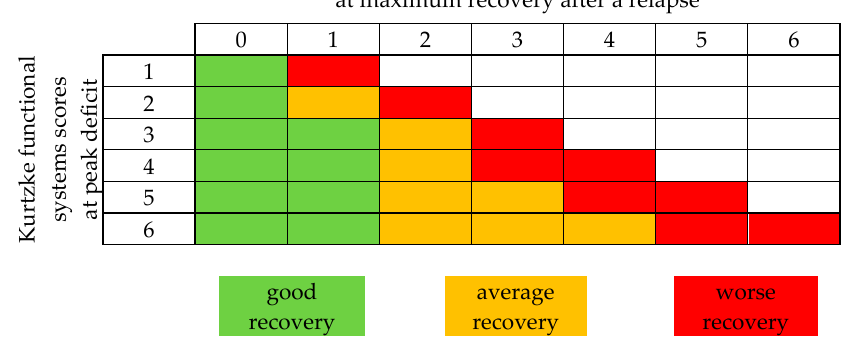
Figure 2. Functional systems score (FSS) based relapse recovery model. Good, average, and worse recovery is assigned based on the peak FSS, and the amount of final stabilized recovery FSS reached. Modified from Conway et al. [48].